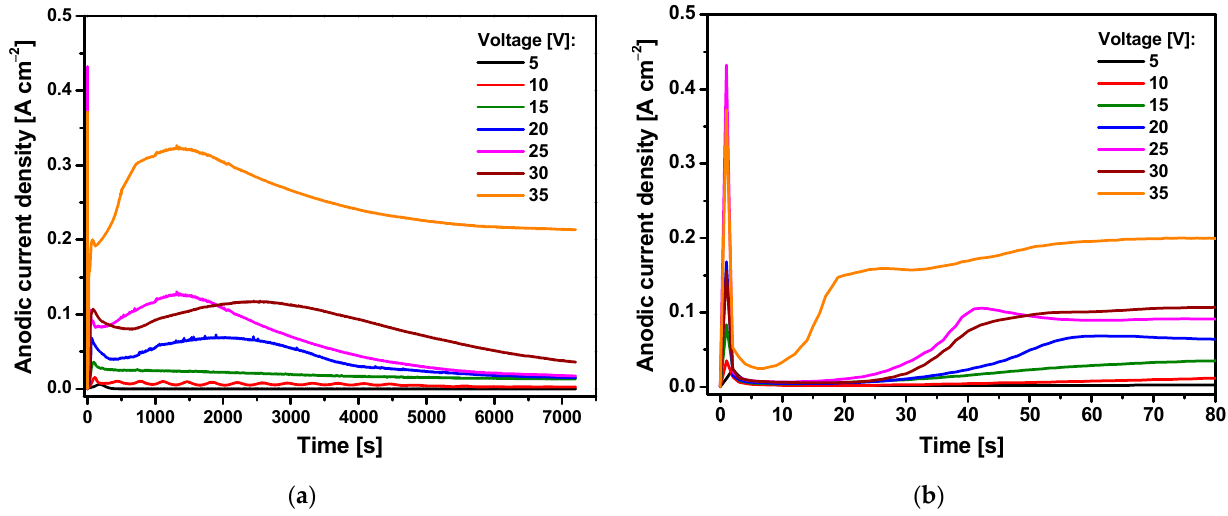
Figure 2. Current transients for the Ti-13Zr-13Nb electrode in 1 M C 2 H 6 O 2 + 4 wt% NH 4 F electrolyte during anodizing for: ( a ) 7200 s; ( b ) first 80 s.